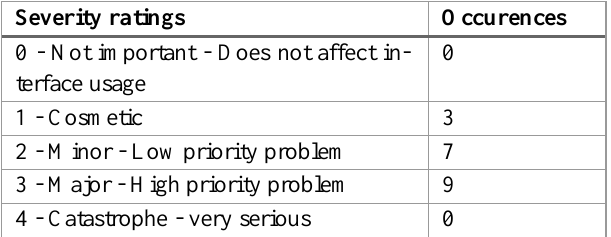
Table 4. Usability problems found in the virtual tablet according to the severity